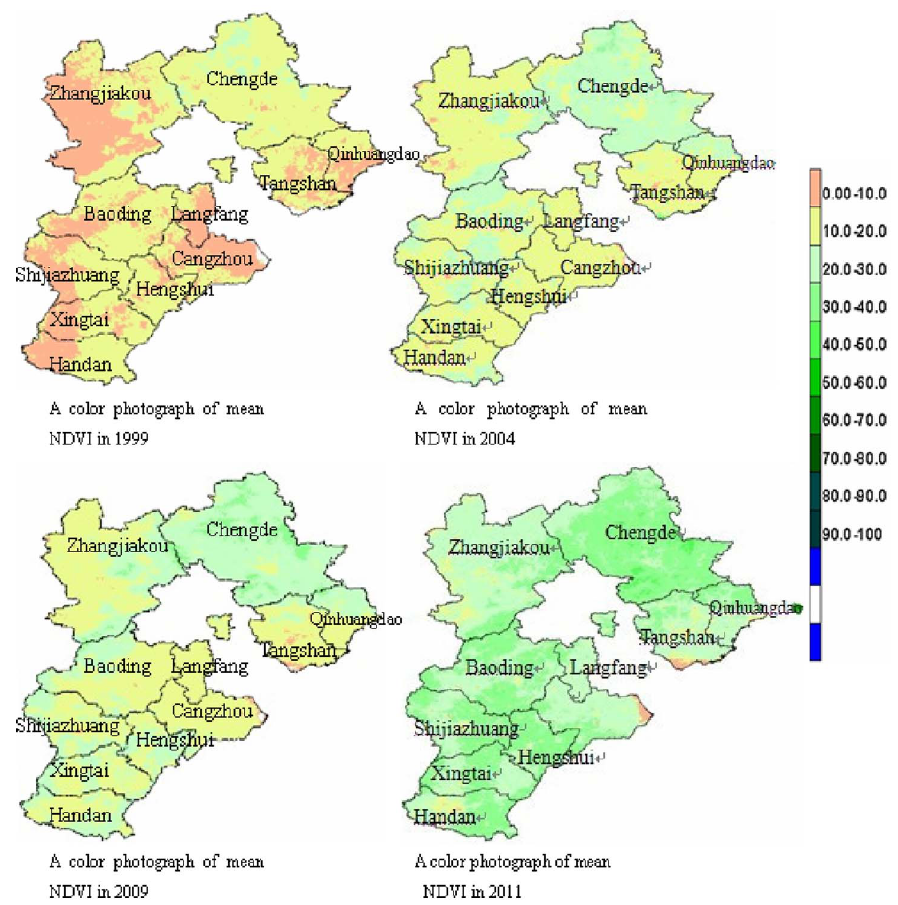
Figure 5. The mean NDVI of cities in Hebei province in 1999, 2004, 2009 and 2011. doi:10.1371/journal.pone.0101348.g005 PLOS ONE |